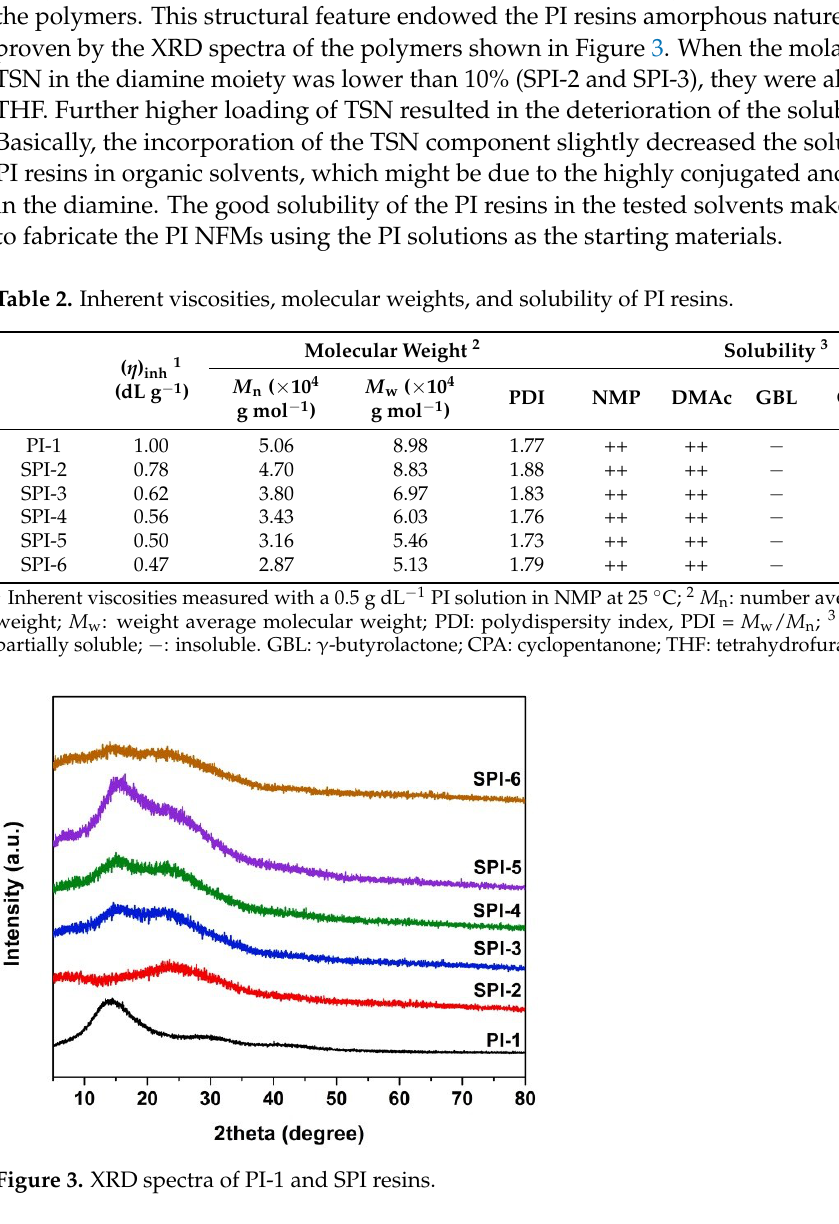
Figure 3. XRD spectra of PI-1 and SPI resins.